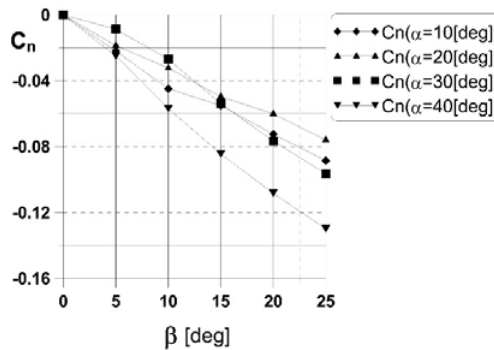
Fig. 11. Yaw moment coefficient Cn versus sideslip angle